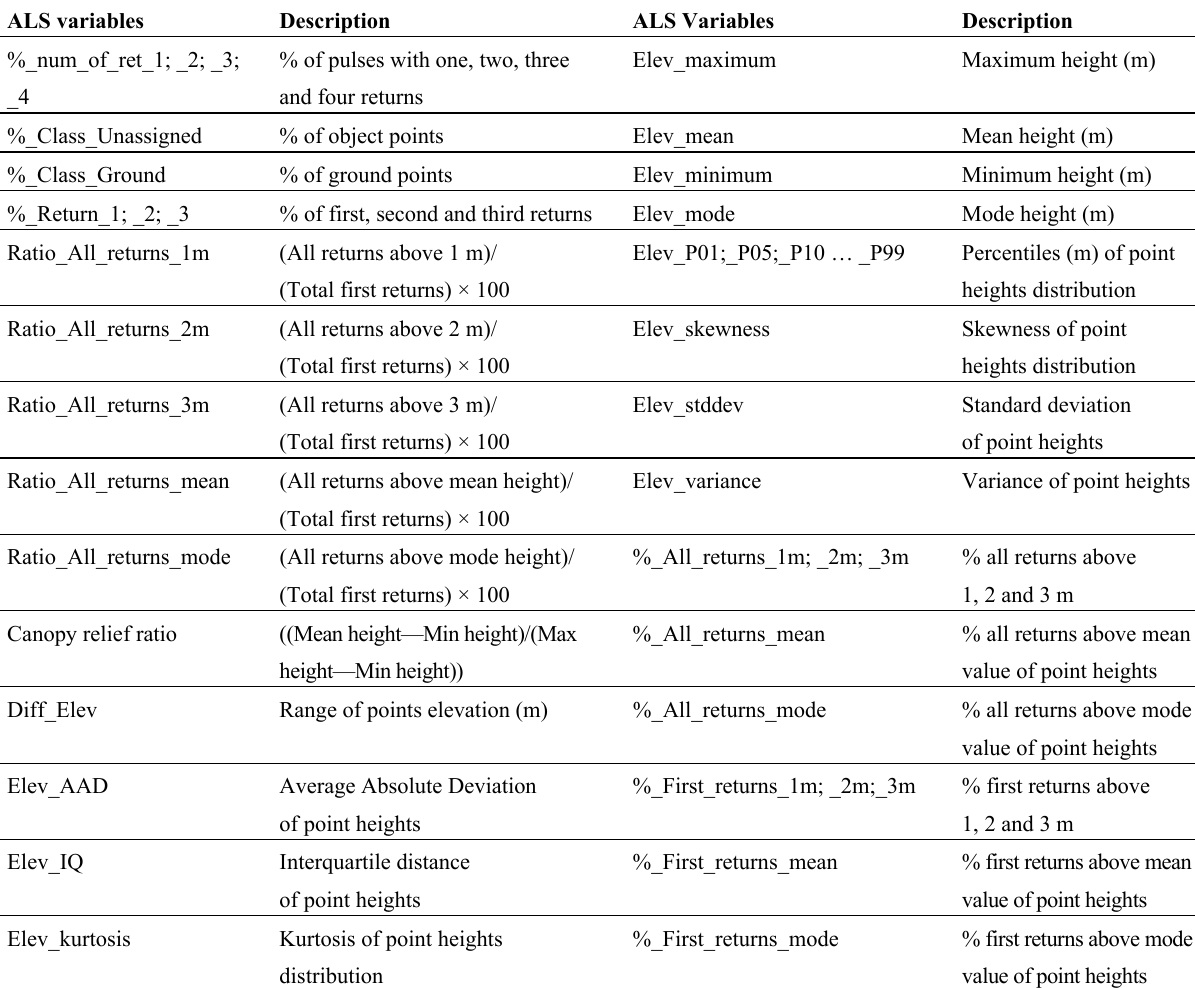
Table 3. ALS-derived variables